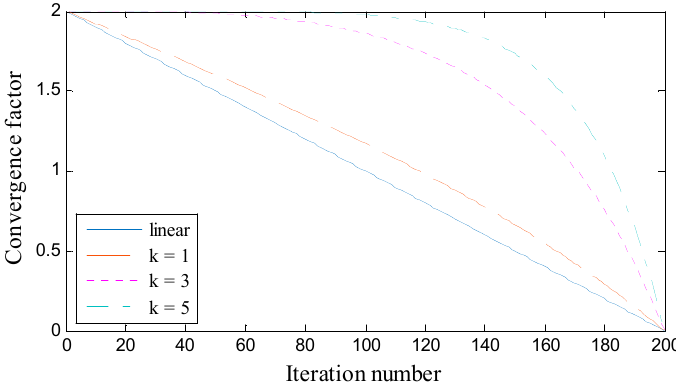
Figure 3. Comparison of convergence factors with different values of k .